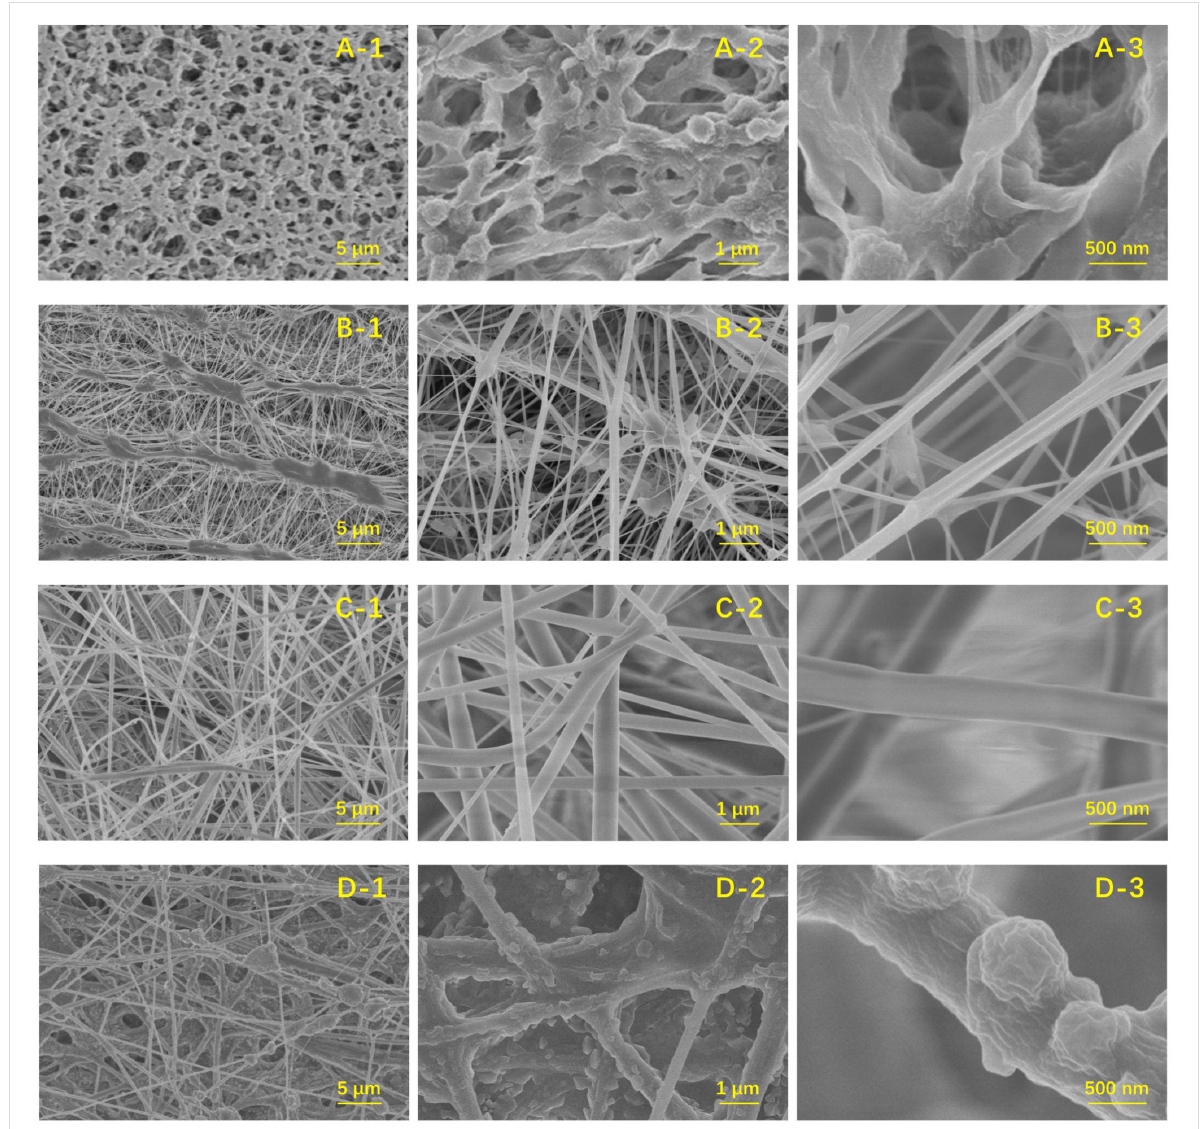
Figure 6: SEM images of the surfaces of (A) the commercial PVDF membrane, (B) the commercial PTFE membrane, (C) the CA-PDTS fibrous mem- brane, and (D) the CA/SiNPs-PDTS fibrous membrane. Figure 6 was reprinted from [125], Desalination, vol. 468, by D. Hou; C. Ding; C. Fu; D. Wang; C. Zhao; J. Wang, “Electrospun nanofibrous omniphobic membrane for anti-surfactant-wetting membrane distillation desalination”, article no. 114068, Copyright (2019), with permission from Elsevier. This content is not subject to CC BY 4.0.